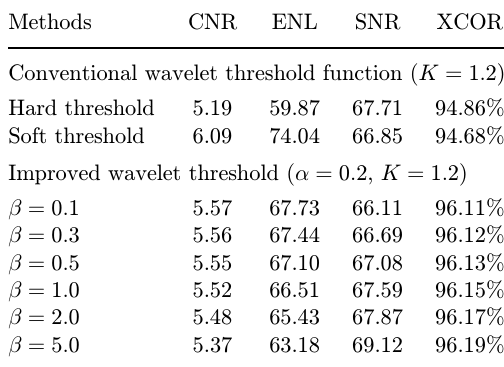
Table 3. Image quality metrics when (cid:2) varies from